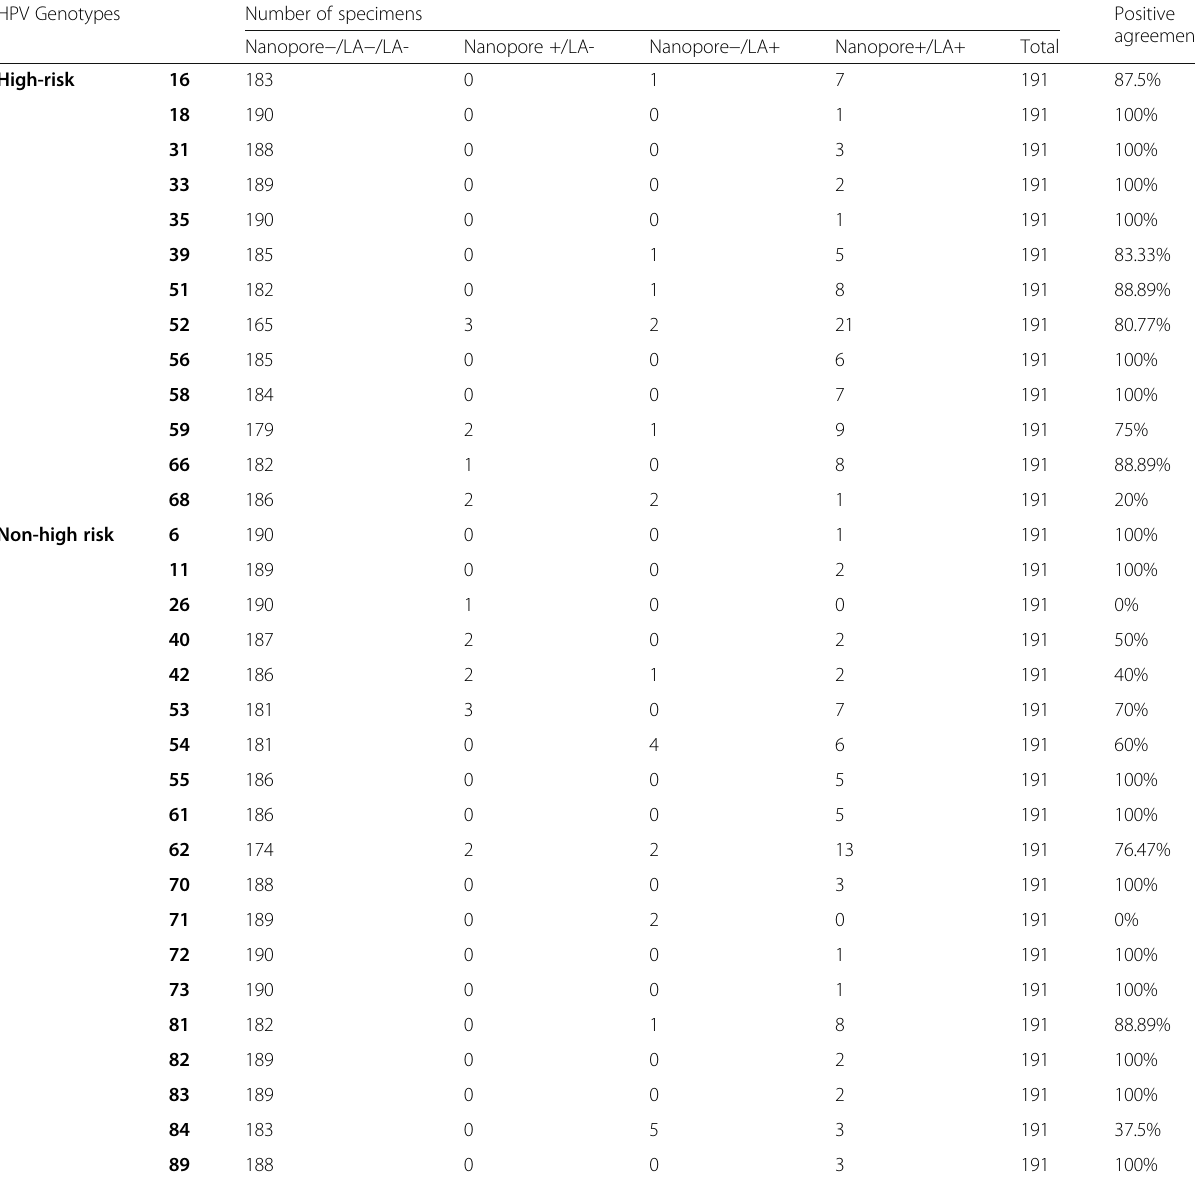
Table 6 Per HPV type positive agreement between Roche Linear Array Genotyping Test (LA) and Nanopore HPV Genotypes High-risk